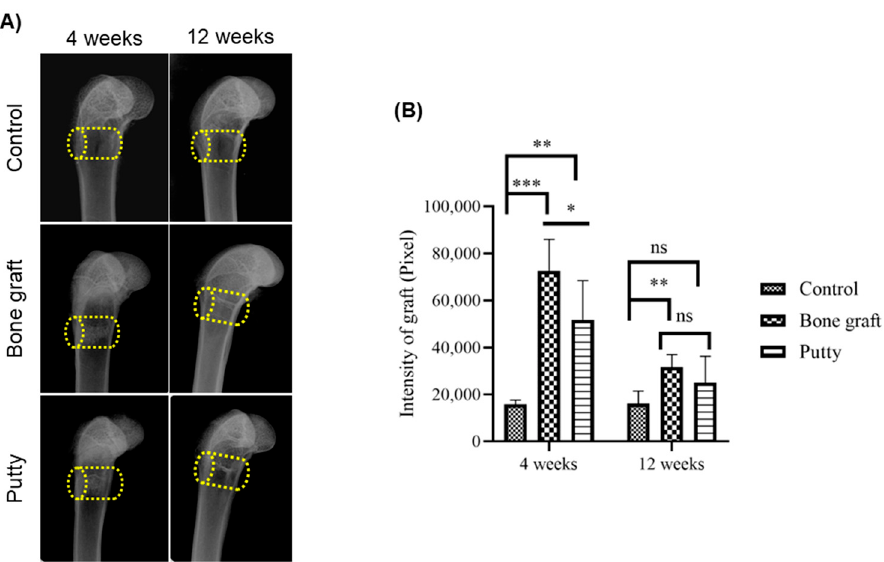
Figure 4. Lateromedial radiographic assessment of the critical-sized bone defects. ( A ) Representative lateromedial radiographic image. ( B ) Radiographic quantification of resorption of the bone graft and putty after implantation. The yellow cylinder indicates the defect site. The significance was set at ns- ( p > 0.05), *—( p < 0.05), **—( p < 0.001), ***—( p <